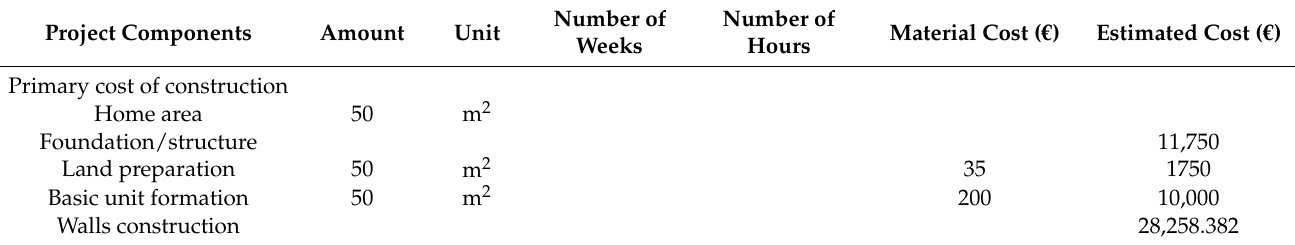
Table 8. Cost estimation of geopolymer 3D printed house on a construction